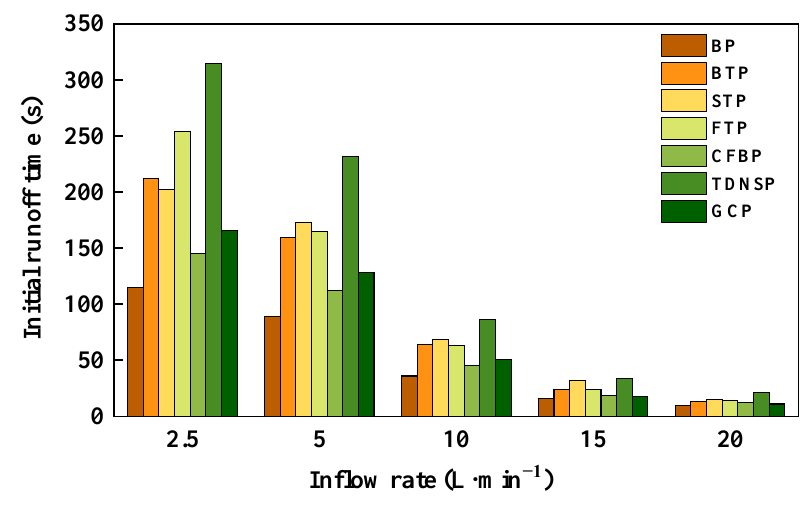
Figure 5. Initial runoff time.